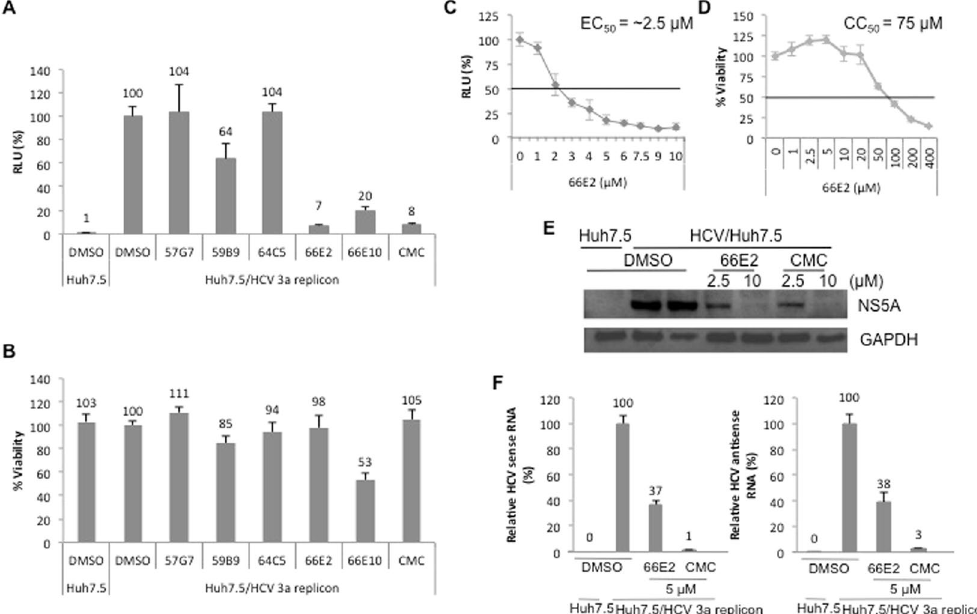
Figure 2. Assays with HCV genotype 3a replicon. ( A ) G418 resistant HCV-3a replicon expressing Huh7.5 cells were treated with indicated compounds for 48 h and the firefly luciferase activity was plotted as relative luciferase units (RLU). DMSO treated HCV-3a replicon expressing Huh 7.5 cells was taken as 100%. ( B ) The toxicity of these compounds in the replicon expressing cells was measured using WST-1 assay reagent. The values are depicted as percentages with the DMSO treated cells taken as 100%. ( C ) The replicon expressing cells were treated with varying concentrations of 66E2 and relative luciferase unit is plotted against the concentration of 66E2. EC 50 is the compound concentration that inhibits 50% of viral replication (RLU). ( D ) Huh7.5 cells were treated with indicated concentrations of 66E2 and cytotoxicity determined using WST-1 assay reagent. The values are plotted as percentages with the DMSO treated cells taken as 100%. CC 50 is the compound concentration that produces 50% of cytotoxicity. ( E ) Western blot analysis. Replicon expressing Huh7.5 cells were treated with different concentrations of 66E2 and CMC for 48 hours and expression of NS5A monitored using anti NS5A antibody. Expression of GAPDH was determined for loading control. ( F ) Reverse-transcriptase quantitative PCR analysis was performed to determine the levels of positive and negative sense HCV-3a RNA upon treatment with 66E2 and CMC at 5 μ M for 48 h. The % mean is shown above the bars and the error bars are standard deviations. All the assays in the figure were performed in triplicates and results presented are representative of at least three independent